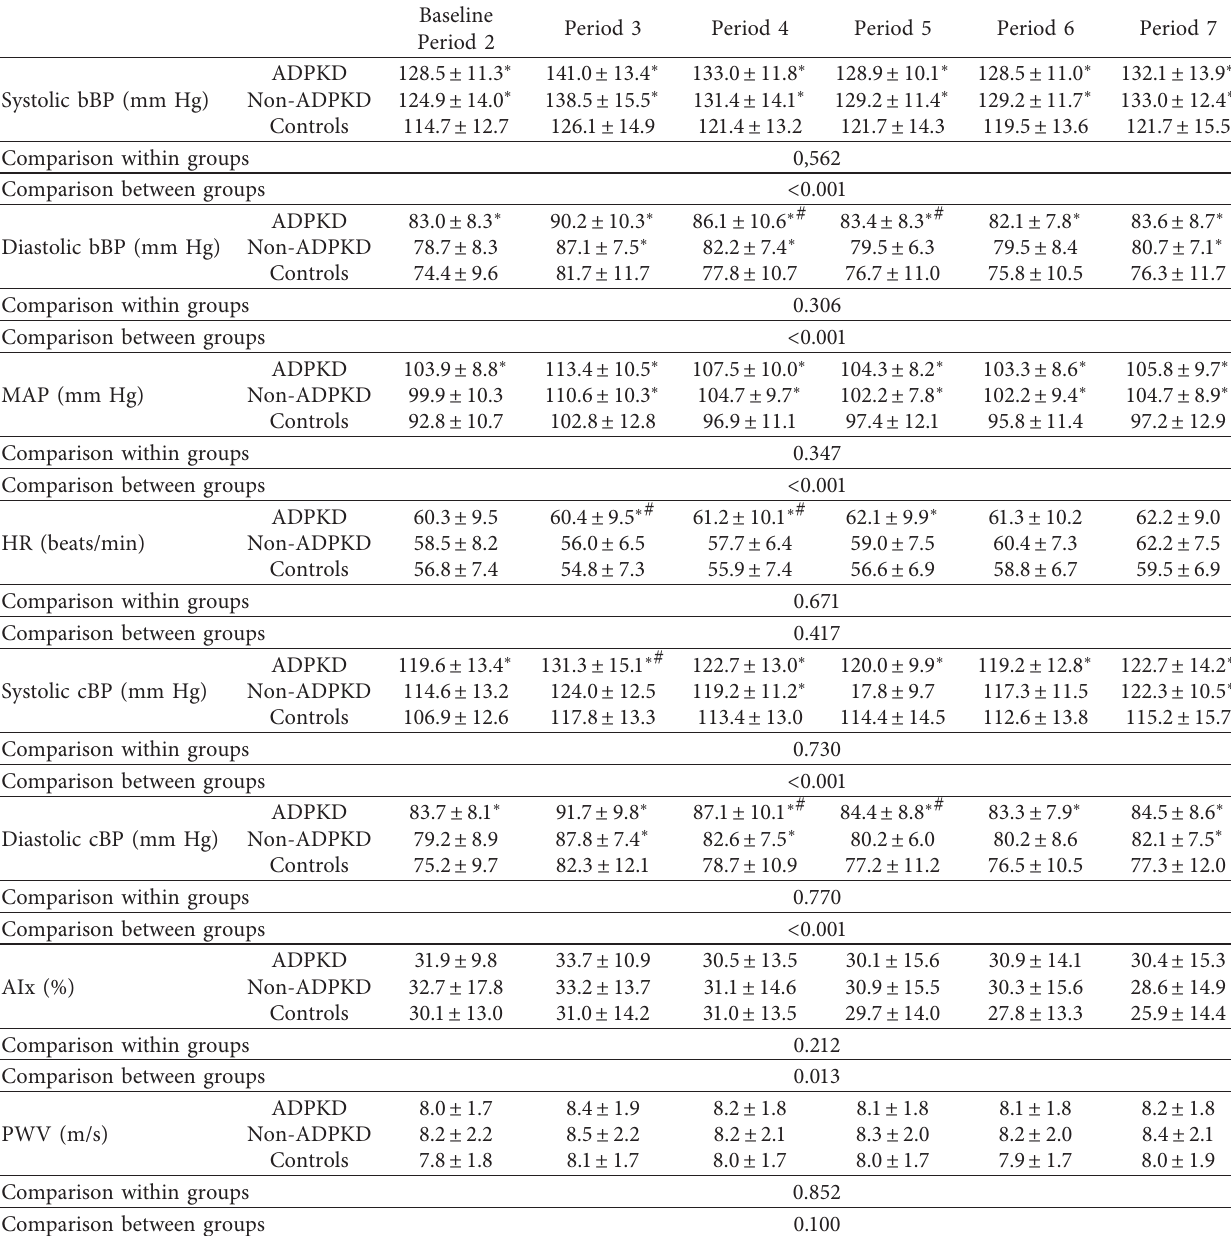
Table 5: Hemodynamics during the urine dilution test in patients with adult dominant polycystic kidney disease (ADPKD), patients with non-ADPKD kidney disease (non-ADPKD), and healthy control subjects